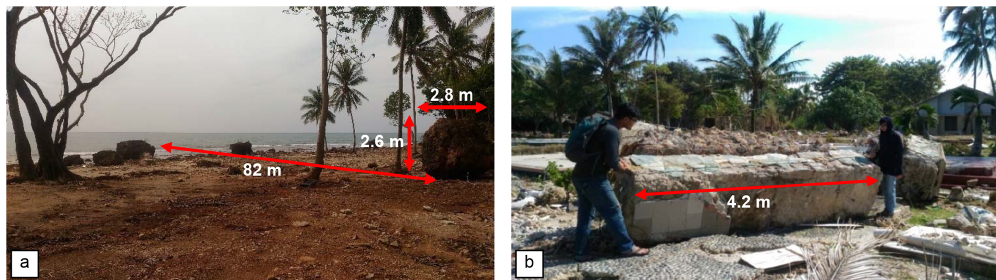
Figure 7. (a) Boulder that moved around 82m inland in Tanjungjaya 2 and (b) an element of seawall that moved around 30m inland in